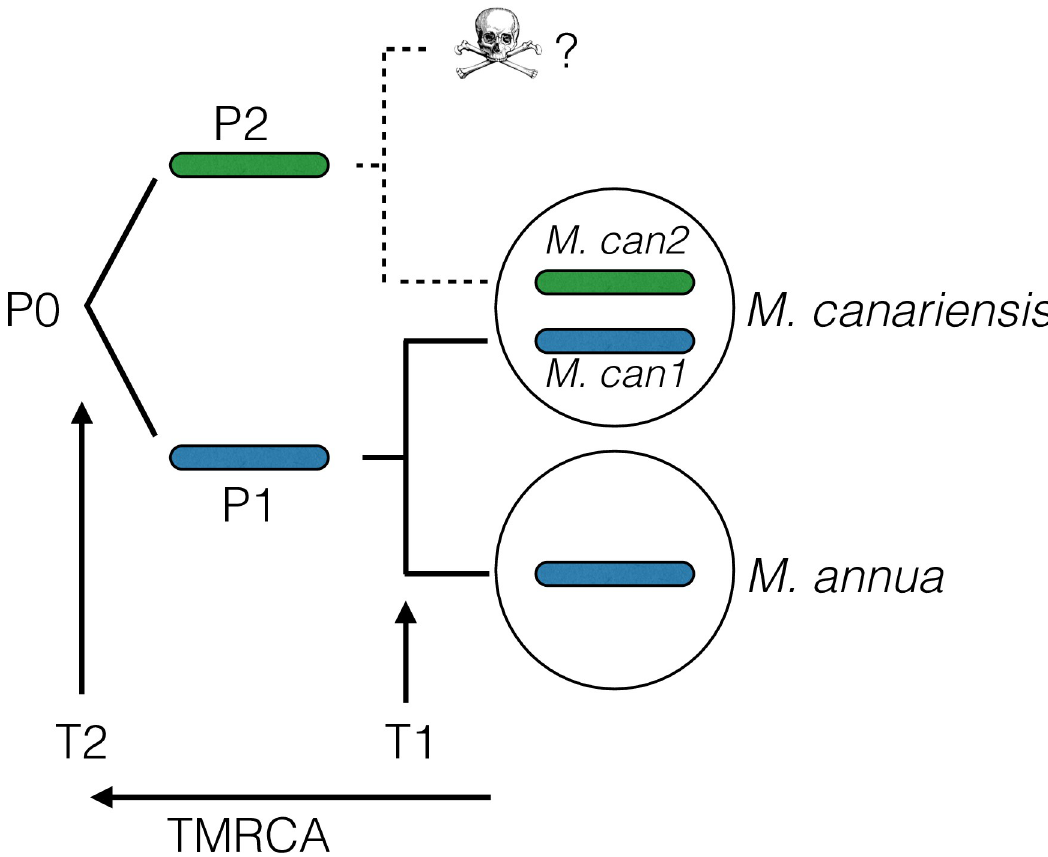
Fig 1. Conceptual approach for identifying the putative progenitors of each of the two subgenomes of M . canariensis , M . can1 and M . can2 . P0 is the most recent common ancestor (MRCA) of the two progenitors of allopolyploid M . canariensis , P1 is the progenitor of the first subgenome of M . canariensis , M . can1 , and the MRCA of M . can1 and extant diploid M . annua . P2 is the progenitor of the second subgenome of M . canariensis , M . can2 , and a second likely extinct lineage. T1 and T2 are the times to the most recent common ancestors (TMRCA), indicated by the coalescence time arrow. We assigned transcripts from M . canariensis to one or other of the two subgenomes on the basis of silent-site divergence, dS, from the homologous sequence in M . annua : we inferred that transcripts with lower dS were derived from P1, whereas those with a higher dS were derived from P2 (because they share the more ancient MRCA with M . annua ,